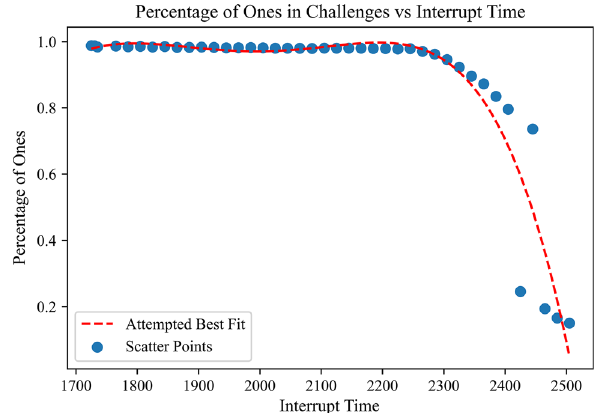
Fig. 3 Ratio of 1’s and 0’s for different program interrupt